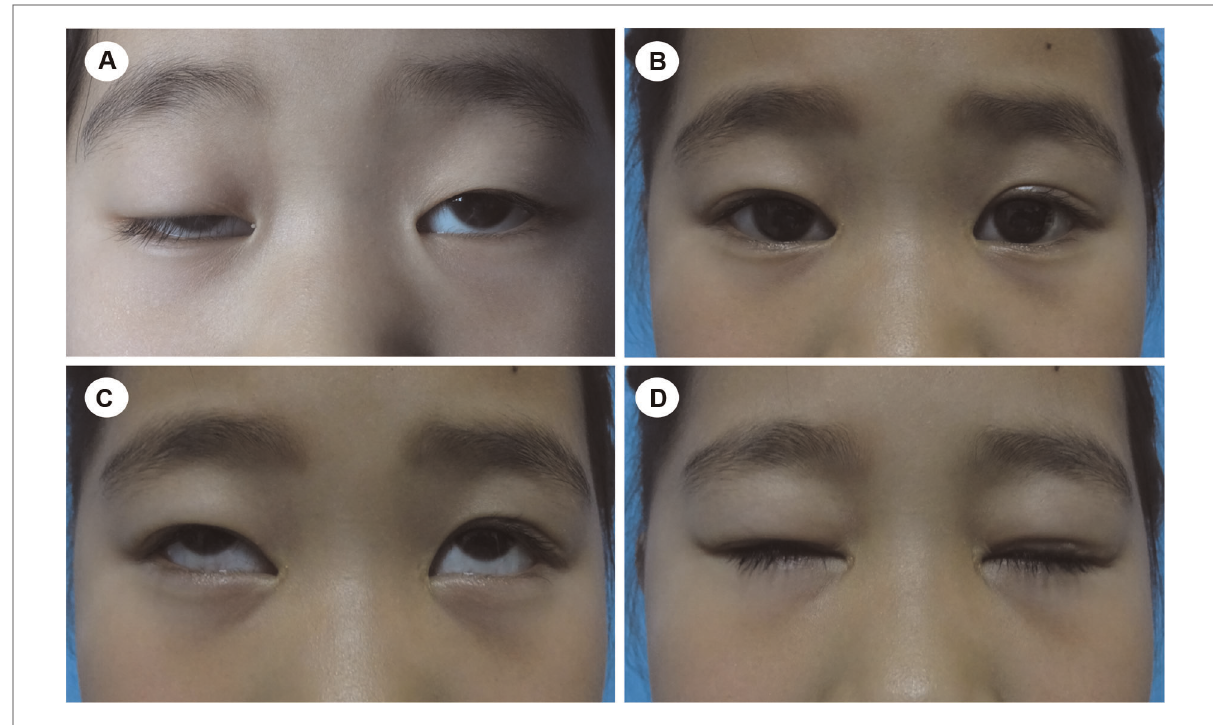
FIGURE 5 A 6-year-old girl with congenital blepharoptosis OU. ( A ) preoperative appearance; ( B ) image of the patient eight months after CFS+LM suspension; ( C,D ) eye movement was normal and lagophthalmos was